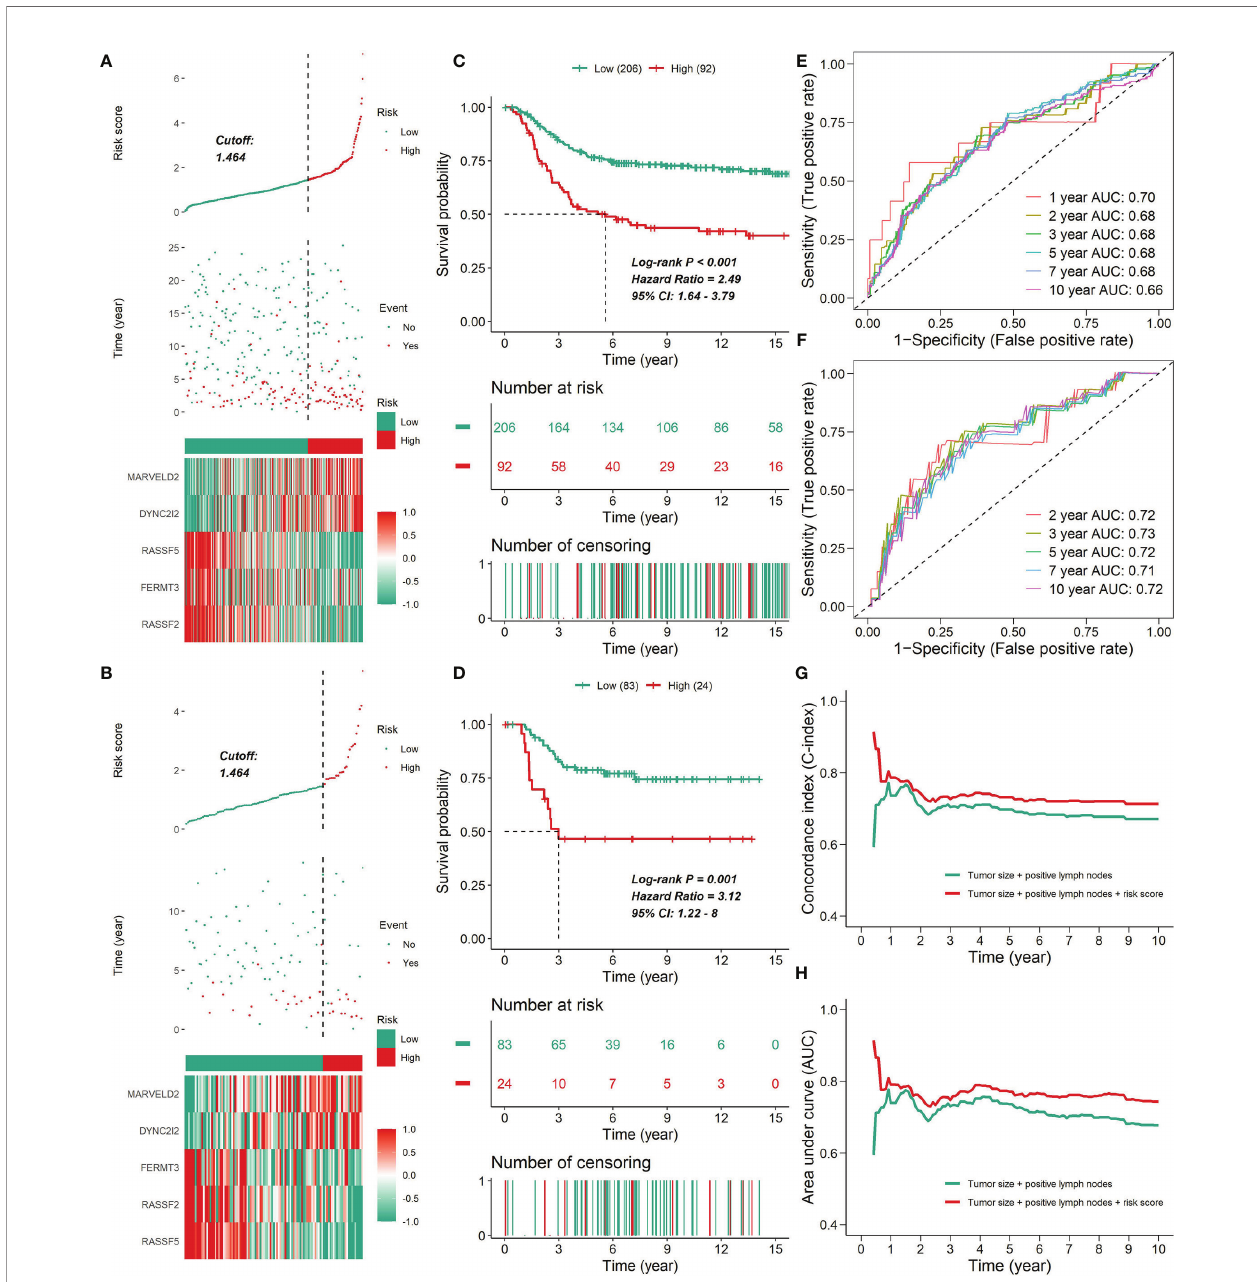
FIGURE 11 | The prognostic value of the fi ve-gene signature. (A, B) The distribution of risk scores, survival time, status and prognostic gene expression patterns for the 298 patients in the testing set (A) or the 107 patients in the test set (B) . For the METABRIC cohort, plots were truncated at 15 years, but the analyses were conducted using all of the data. (C, D) Kaplan-Meier curves of patients in the high- and low-risk groups in the METABRIC cohort (C) or the GSE58812 cohort (D) . (E, F) ROC analysis of the fi ve-gene signature for prediction of survival risk in the training set (E) or the test set (F) . (G, H) Time-dependent C-index curves (G) or time-dependent ROC curves (H) with two Cox proportional hazards models for DSS (based on the METABRIC cohort); one included two covariates (tumor size and number of positive lymph nodes), and the other added immune clusters as covariates. The C-index was internally validated using Bootstrap cross validation for 1000 times. The signi fi cant difference in the C-index and AUC was observed after one